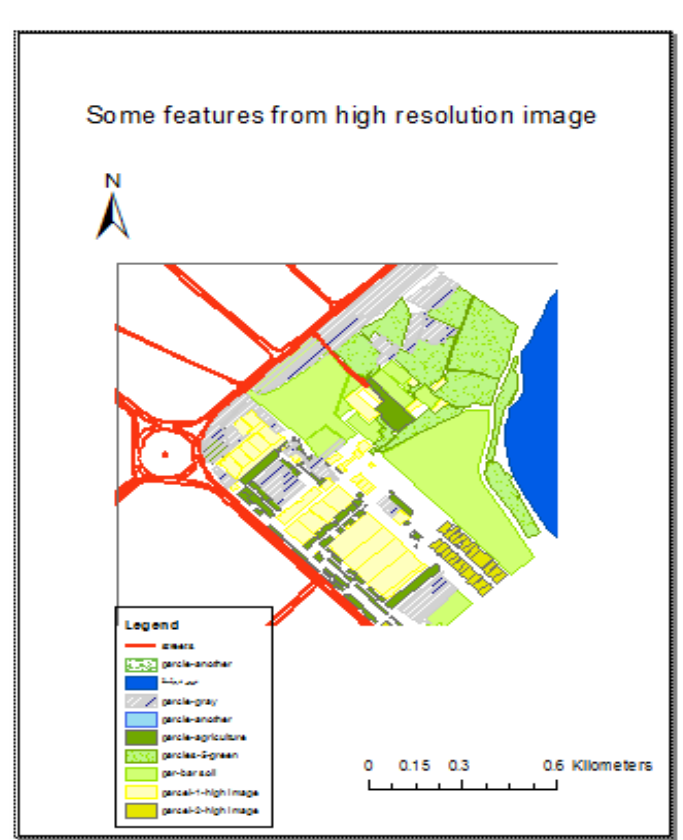
Fig.20: Showing Map at 1:10,000 scale for features producing in high resolution